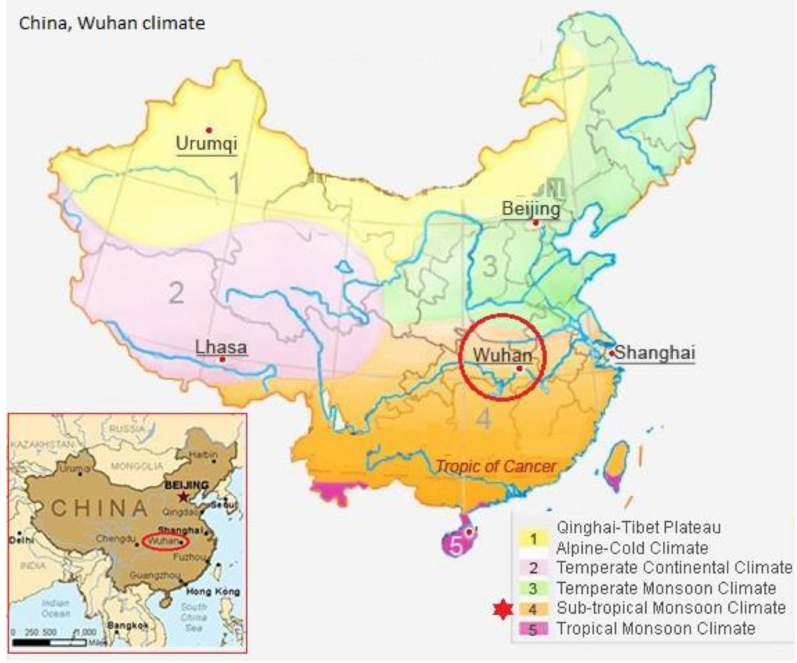
Figure 1. Map of China; Wuhan location and